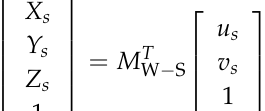
Figure 7. The merged 0.5 m RGB image and the vectorization result.